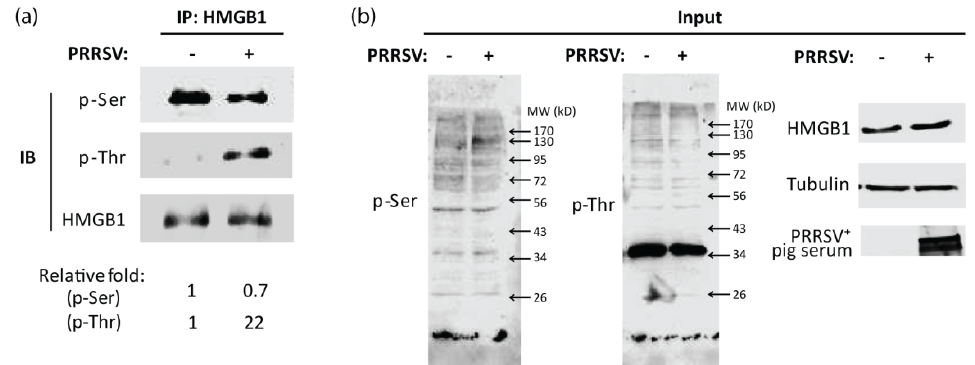
Figure 1. PRRSV infection induces HMGB1 phosphorylation at threonine residues. The MARC-145 cells were infected with PRRSV stain HuN4 at a multiplicity of infection (MOI) of one and 24 h post-infection (hpi), harvested for further analysis. ( a ) PRRSV infection increases the phosphorylation level of HMGB1 at threonine residues. Immunoprecipitation (IP) was done with HMGB1 antibodies, followed by immunoblotting (IB) with antibodies against phosphorylated serine (p-Ser), phosphorylated threonine (p-Thr), and HMGB1. Relative levels of p-Ser and p-Thr are shown as folds below the images after normalization with HMGB1 in densitometry analysis. ( b ) IB results for input whole cell lysate. Whole gel images for p-Ser and p-Thr IB are shown. PRRSV-positive (PRRSV + ) pig serum was also used for detecting viral proteins.